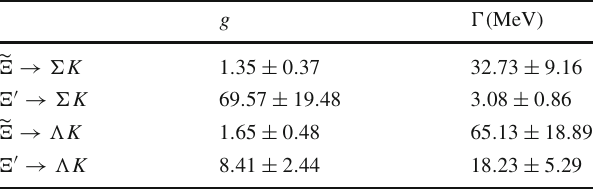
Table 3 The sum rule results for the strong coupling constants and decay widths of the first orbitally and radially excited (cid:2)